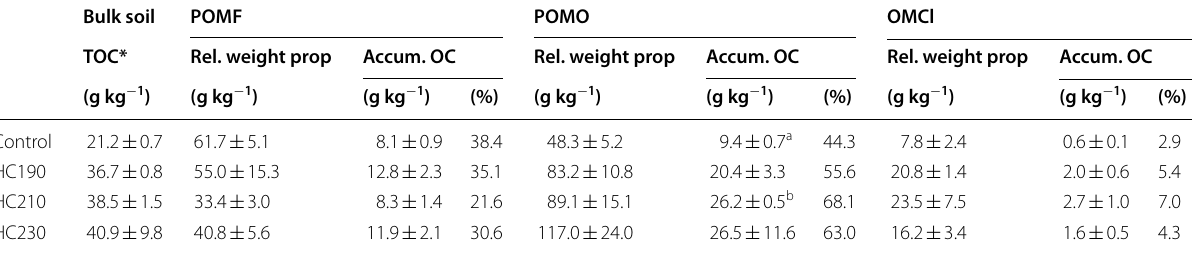
Table 2 For the control and hydrochar (HC)-amended soils: The total organic carbon (“TOC”) content of the bulk soil [including sand and silt fractions (data not shown)] and each soil organic matter (SOM) fraction in g kg − 1 , as well as the relative weight proportion (“Rel. weight prop.”) in g kg − 1 , and the resultant accumulated organic carbon (“Accum. OC”) in g kg − 1 and as a percentage (%) of the bulk soils TOC in each SOM fraction after 1 year